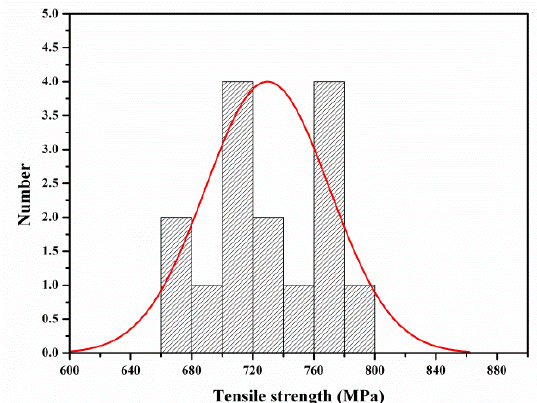
Fig. 2 Number of specimens and normal distribution of tensile strength of Si 3 N 4 in Kimoto et al.